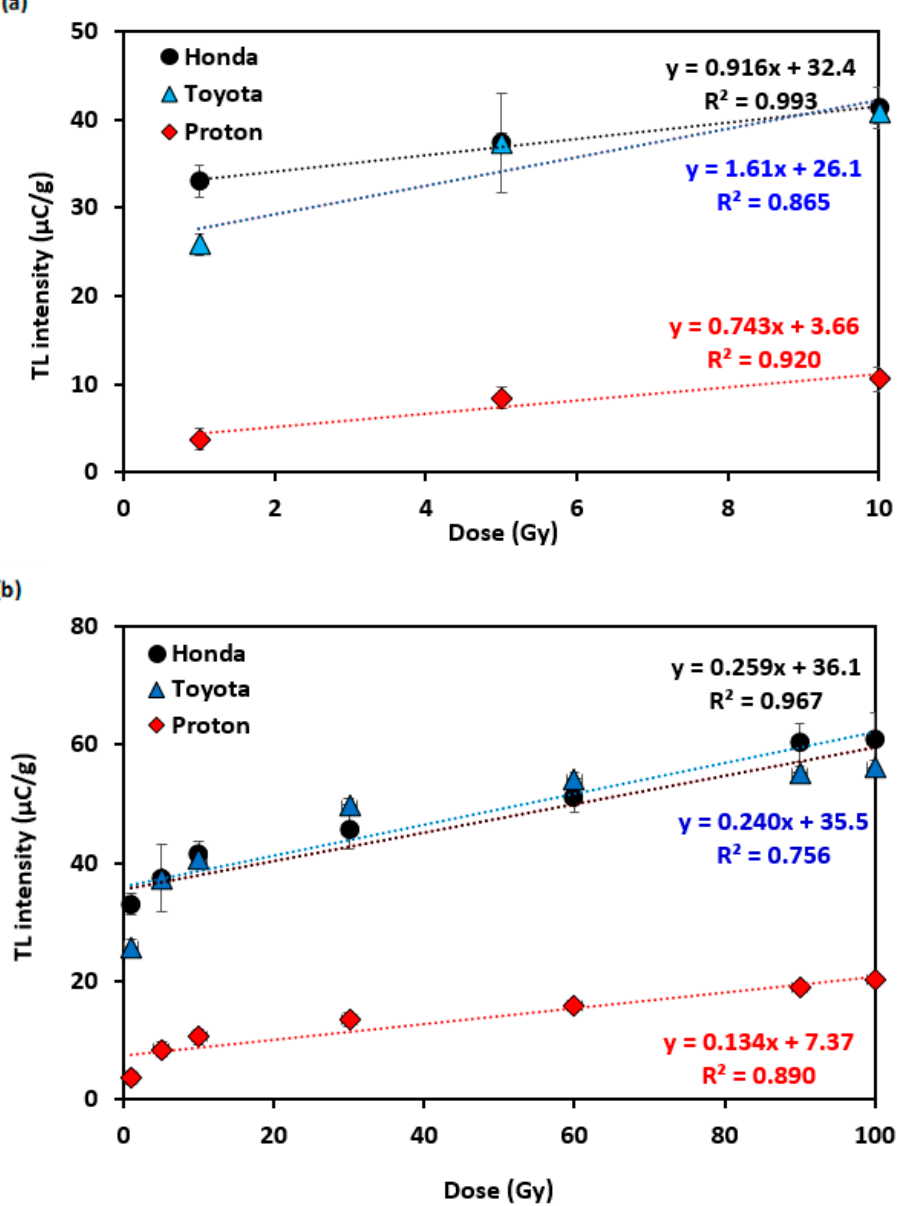
Figure 4. Dose response for 60 Co exposures: ( a ) 1–10 Gy; ( b ) 1–100 Gy. The error bars are standard error of the mean, with in some cases the error bars smaller than the size of the data points. In ( b ) the linear fittings are biased towards the more elevated doses, ( a ) better showing the situation at doses up to 10 Gy.